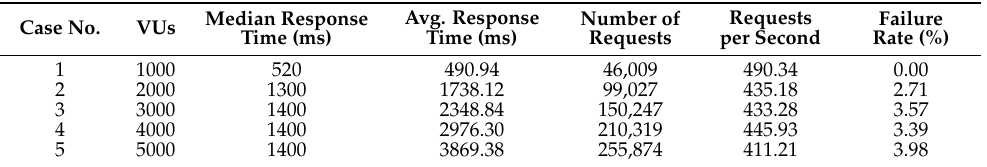
Table 2. Performance for 1-policy routing: Policy 2. Avoid crowded areas.